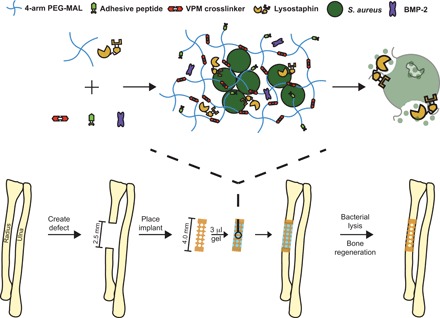
Lysostaphin and BMP-2 co-delivery to a critical-sized segmental bone defect.A 2.5-mm segment of the radius is removed to create a critical-sized bone defect that does not spontaneously heal. A PEG-4MAL hydrogel functionalized with the adhesive ligand GFOGER and loaded with lysostaphin and BMP-2 is synthesized with S. aureus. Lysostaphin enzymatically creates holes in the bacterial cell wall, leading to lysis. These infected hydrogel scaffolds are loaded into a 4-mm polyimide sleeve and placed over the ends of the defect. Co-delivery of BMP-2 and lysostaphin results in infection clearance followed by subsequent defect regeneration.